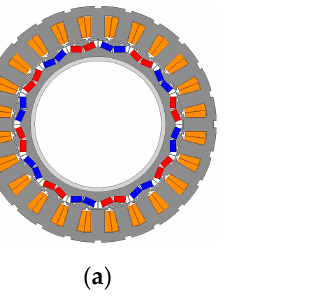
Figure 18. Irreversible demagnetization area of final model: ( a ) Final full model, ( b ) Irreversible demagnetization region in final